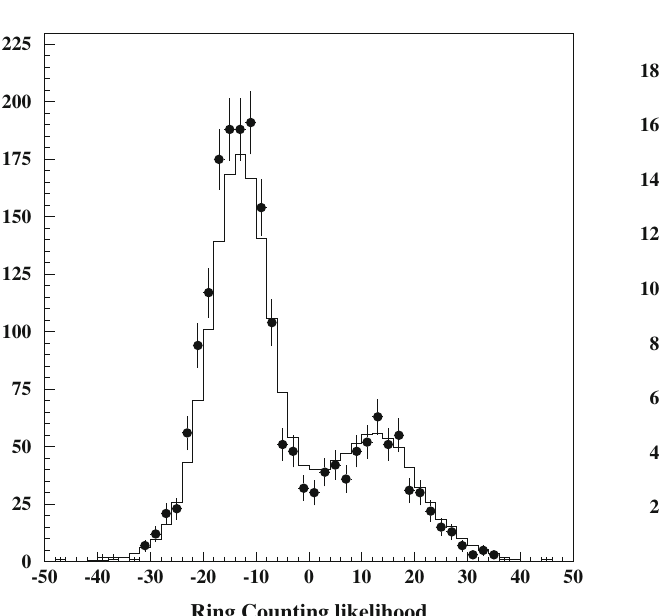
Fig. 31 Particle identification likelihood distribution for SK-2 atmo- sphericfullycontained1ringevents.Closedcircleisdataandhistogram isMCexpectationnormalizedlivetimewithneutrinooscillation.Events with Likelihood < 0 are assigned to be